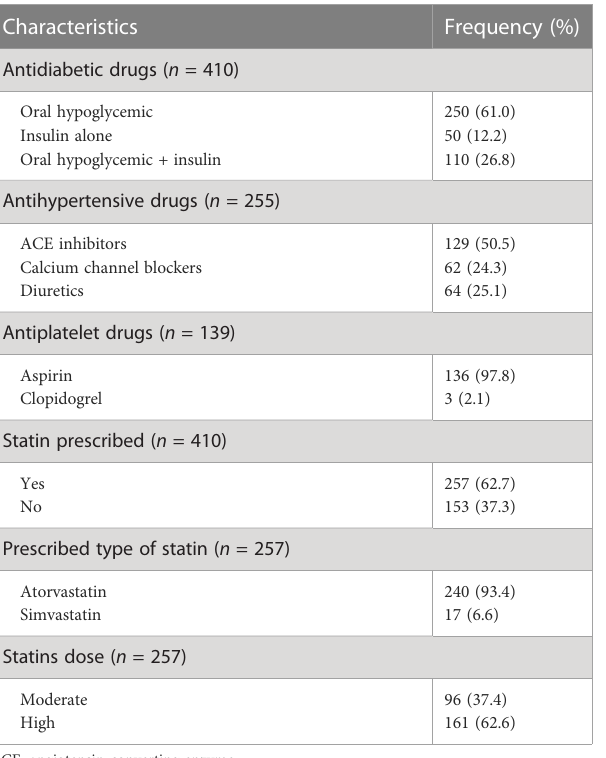
TABLE 2 Prescribing statins and other medications among type 2 diabetes mellitus (T2DM) patients in Jugol General Hospital in Harar, Ethiopia: 2022.